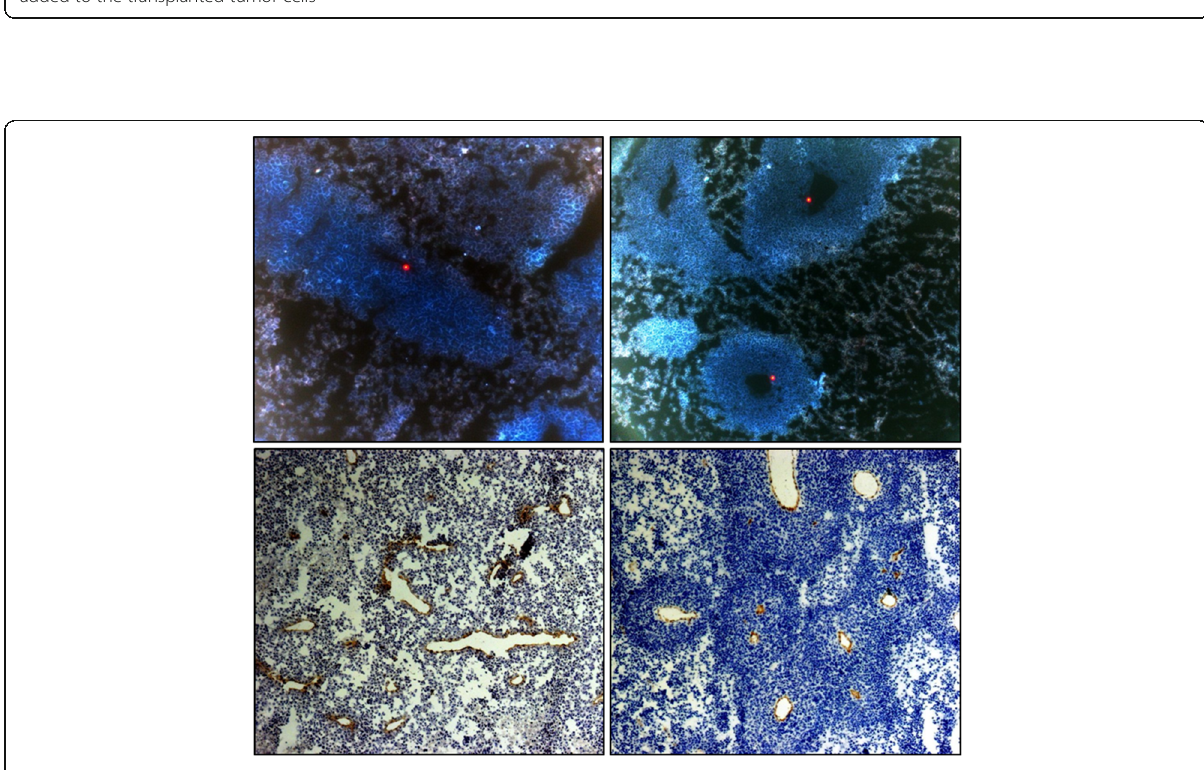
Fig. 4 Growth of xenograft tumors. Increase of the xenograft tumor volumes of the non-small-cell lung cancer (NSCLC) cell lines A549 and H1299, estimated by in-vivo caliper measurements. In co-transplanted tumor groups vascular growth promoters (RGE cells, rHu-VEGF-165, rHu-FGF-b) were added to the transplanted tumor cells